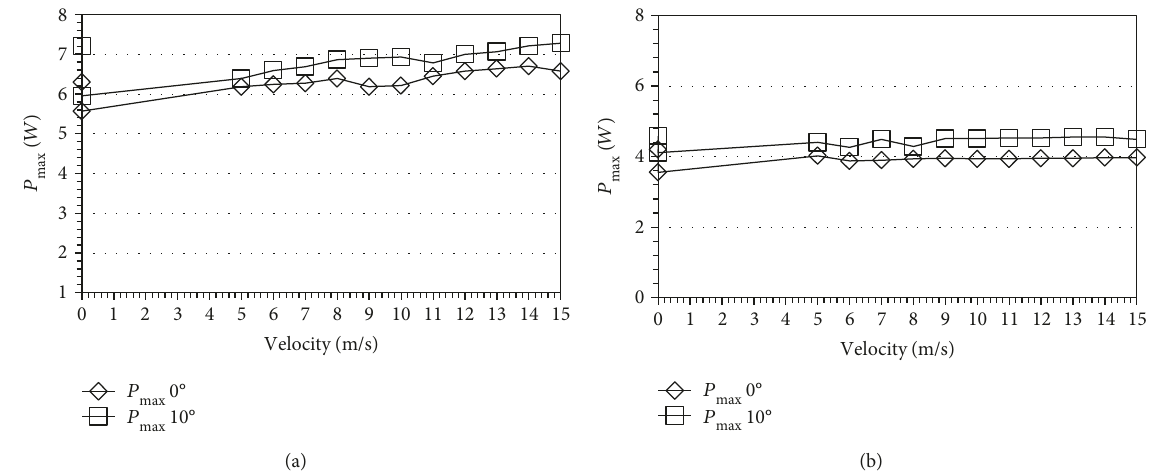
Figure 7: Modules power at di ff erent velocities. (a) Monocrystalline and (b) polycrystalline.